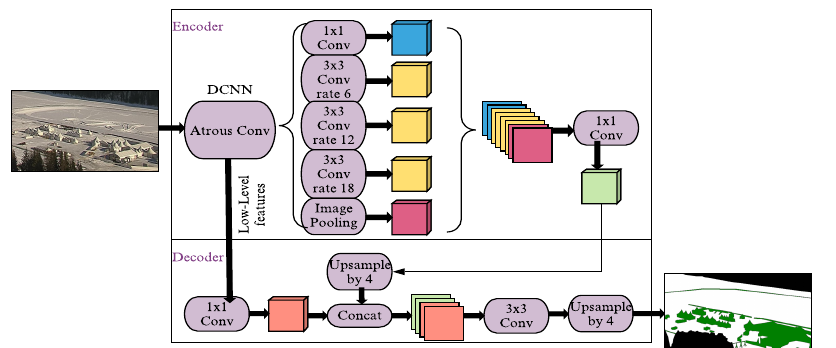
Figure 3: Deeplab v3+ architecture. Best if viewed on screen.